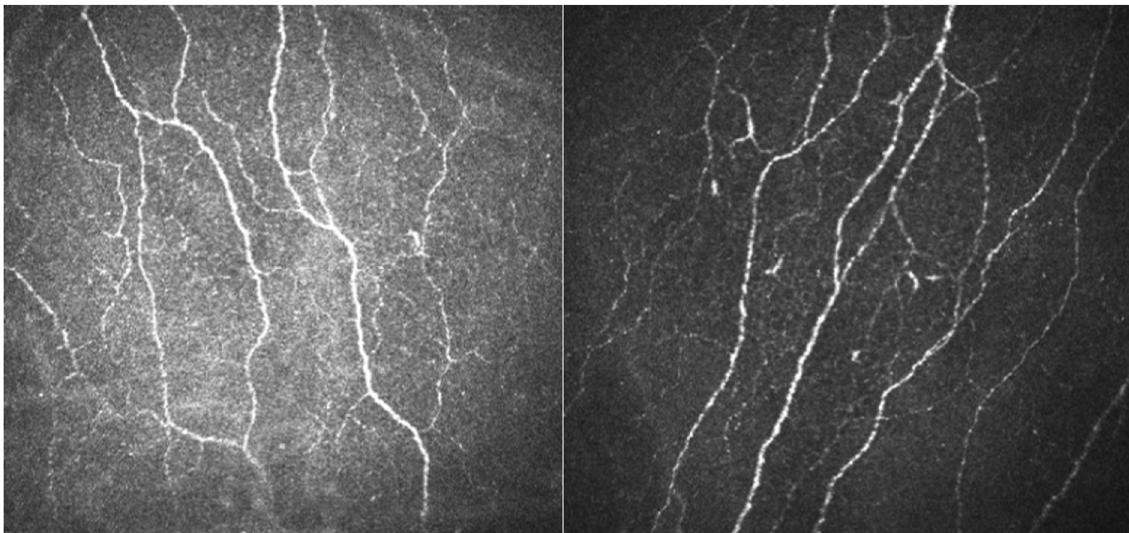
Figure 4. Corneal confocal microscopy with the assessment of the subbasal plexus. Semi-automatic analysis of the obtained images has shown the following results (Table 1).